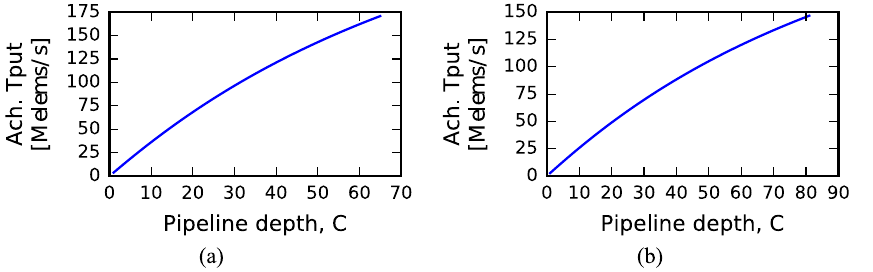
Figure 18. Total achievable throughput prediction plots vs. pipeline depth for the SHA-2 application. The parameters used are N = C and S = 0 (i.e., no secondary memory). ( a ) SHA-256 ( b )